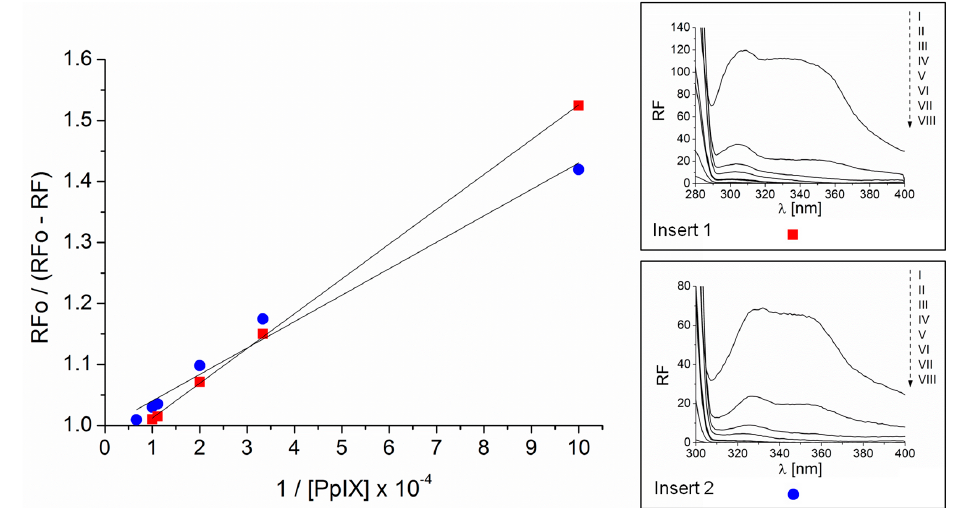
Figure5. Stern-Volmer dependence for the PpIX-HSA complex excited at 280 nm ( ■ ) ( y = 0.0434 x + 0.9971) and 295 nm ( ● ) ( y = 0.0571 x + 0.9551). Data determined from emission fluorescence spectra.